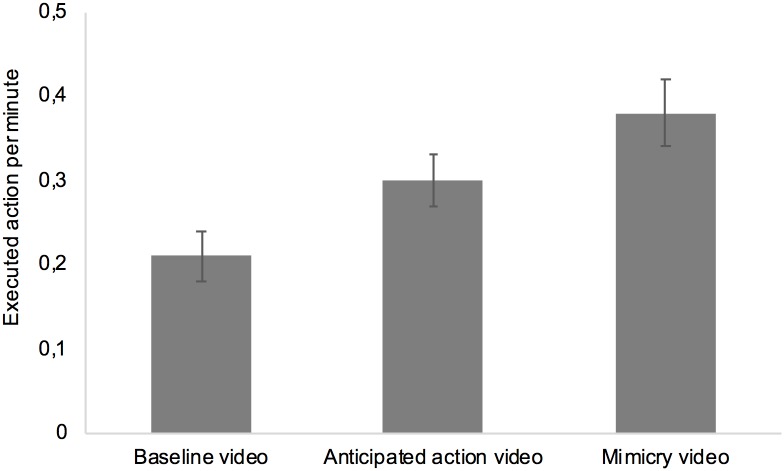
Amount of executed nose touching actions per minute as a function of observed video.Error bars represent standard errors.